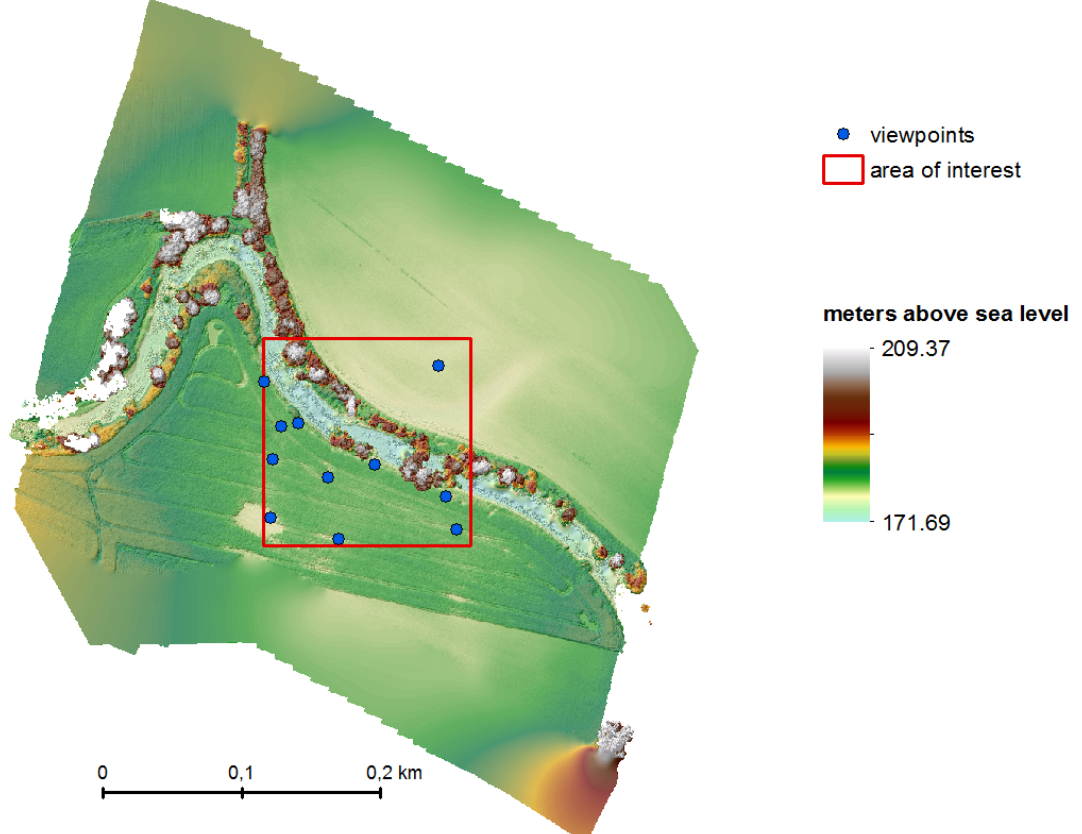
Figure 2. Area of the research – river Opava near the Ostrava city (Czech